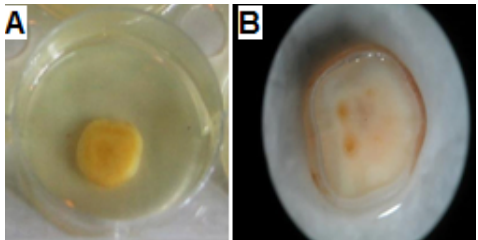
Figure 6. In vitro tooth model assay using saliva-coated hydroxyapatite (S-H) discs. ( A ) Saliva-coated S-H disc in a well of a six-well plate inoculated with S. mutans and treated with MBIC of AKFAs. ( B ) Stereographic image of S. mutans biofilm formed on saliva coated S-H disc.